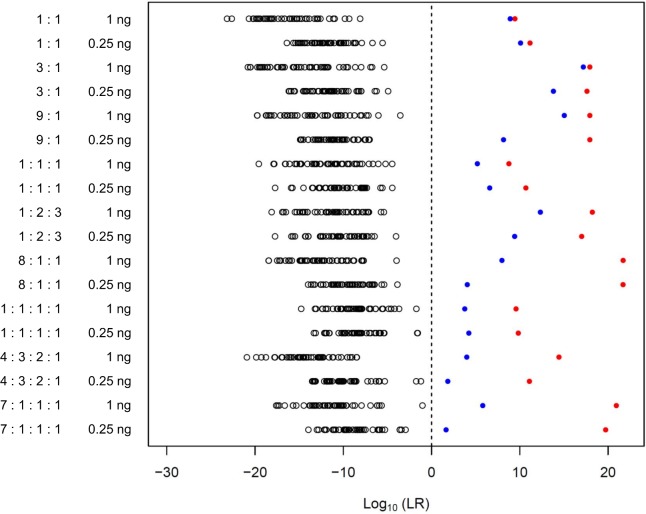
LR values in non-contributor testing are shown in white circles.The red and blue plots represent LR values of the major and minor POIs, respectively.